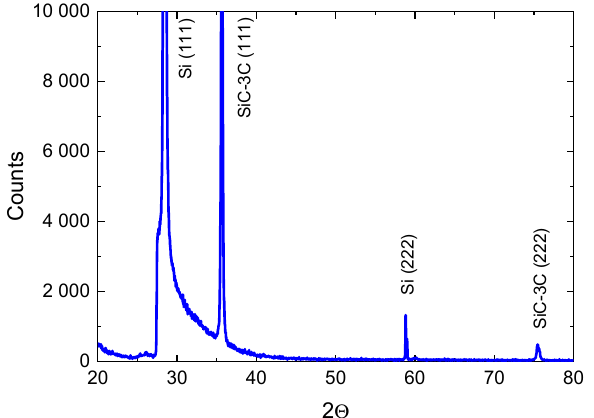
Figure 5. X-ray diffraction spectrum of a 3C-SiC(111)/Si(111) sample grown by the method of coordinated substitution of